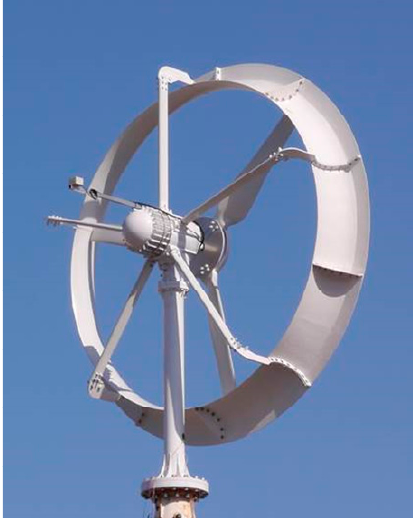
Figure 19. Practical WLT [58] with a duct composed of several parts.